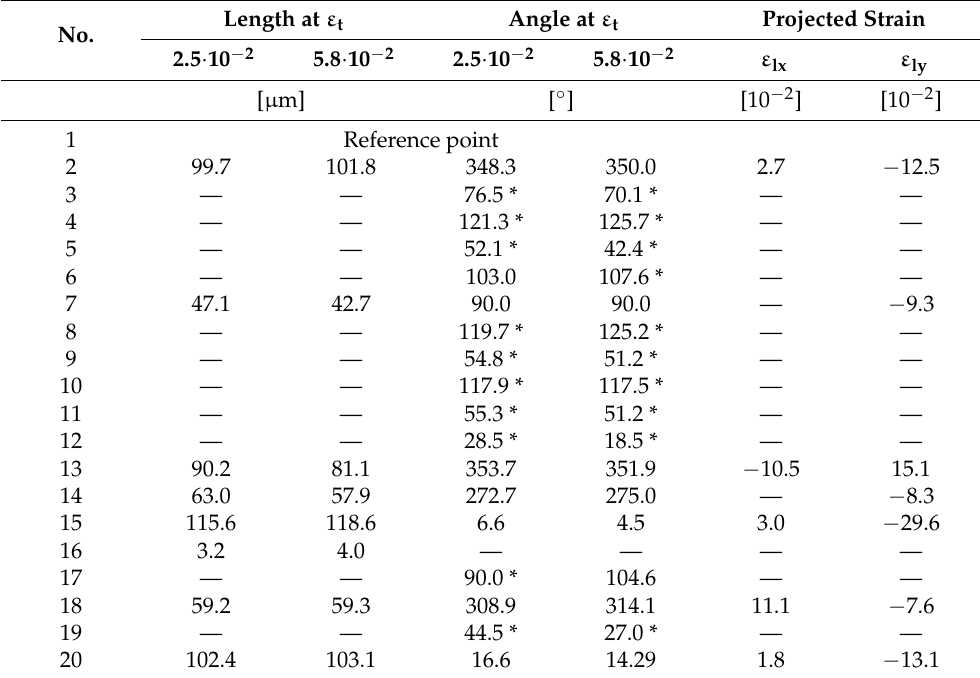
Table 2. Distances and angle of two strain conditions of aligned PCL under tensile load as marked in Figure 10.